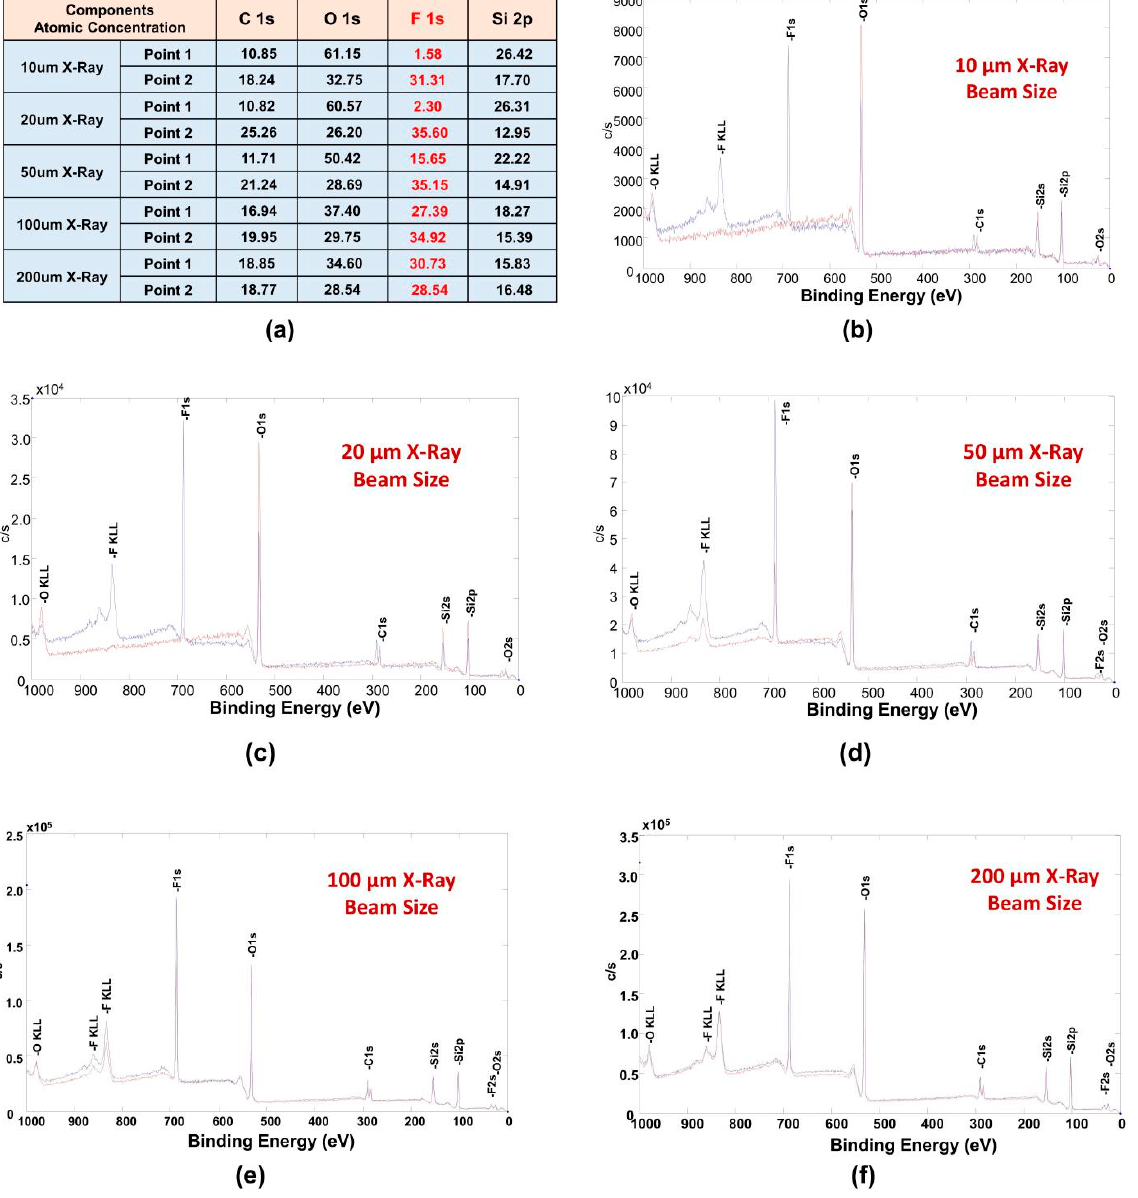
Figure 5. ( a ) Atomic concentration (AC%) of four chemical states (C 1s, O 1s, F 1s, and Si 2p) when the X-ray beam size changed from 10 µm to 200 µm. X-ray photoelectron spectroscopy (XPS) spectra of Point 1 and Point 2 with the X-ray beam changed from 10 µm to 200 µm: ( b ) 10 µm, ( c ) 20 µm, ( d ) 50 µm, ( e ) 100 µm, and ( f ) 200 µm.